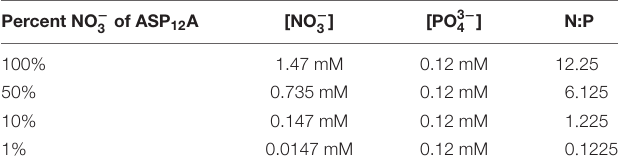
TABLE 1 | Concentrations of NO − 3 and PO 3 − 4 of the different growth